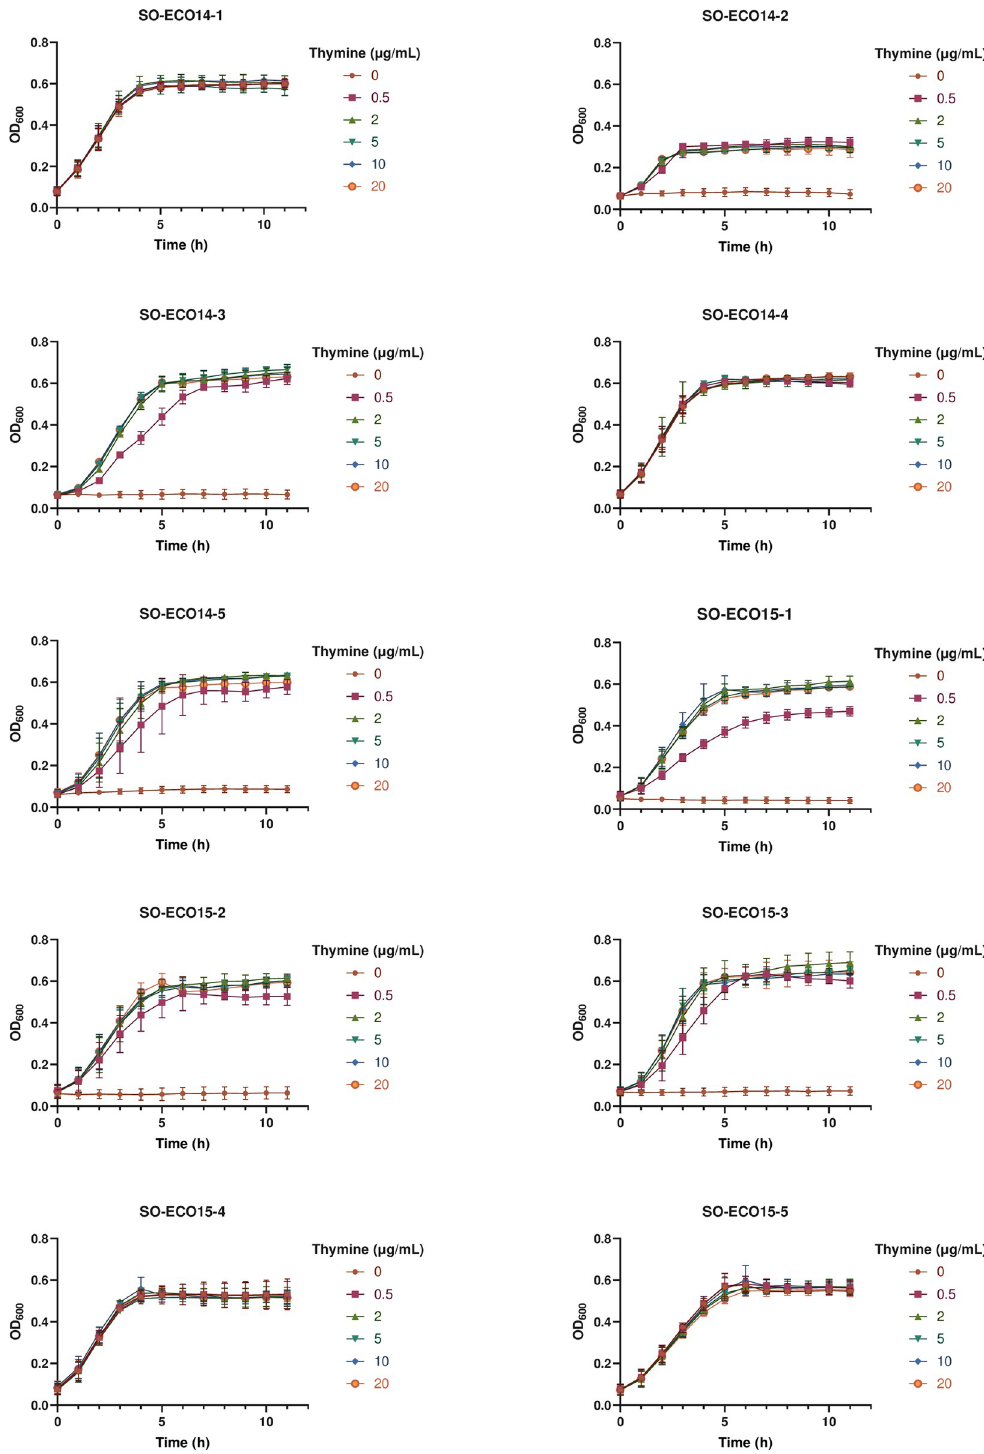
Fig 2. Growth (OD 600 ) of E . coli BSI isolates at 37˚C in liquid M9 medium with added thymine.